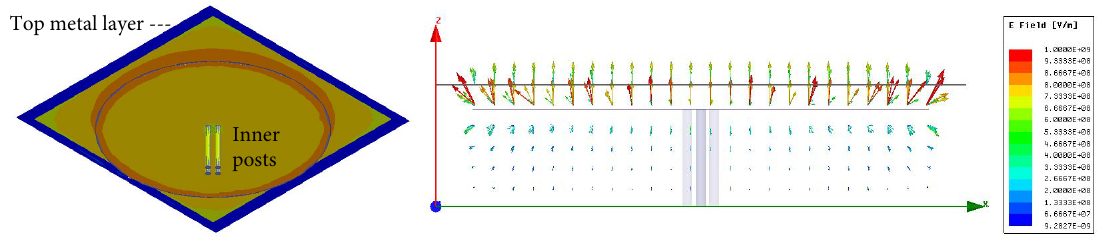
Figure 2. 3D E-field distribution for the proposed embedded coaxial SIW resonator in the gap that separates the disk plate and the top ground